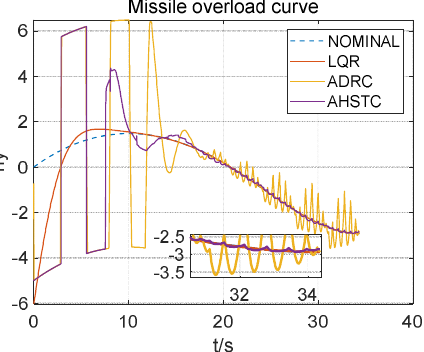
Figure 9. Control tracking curve.